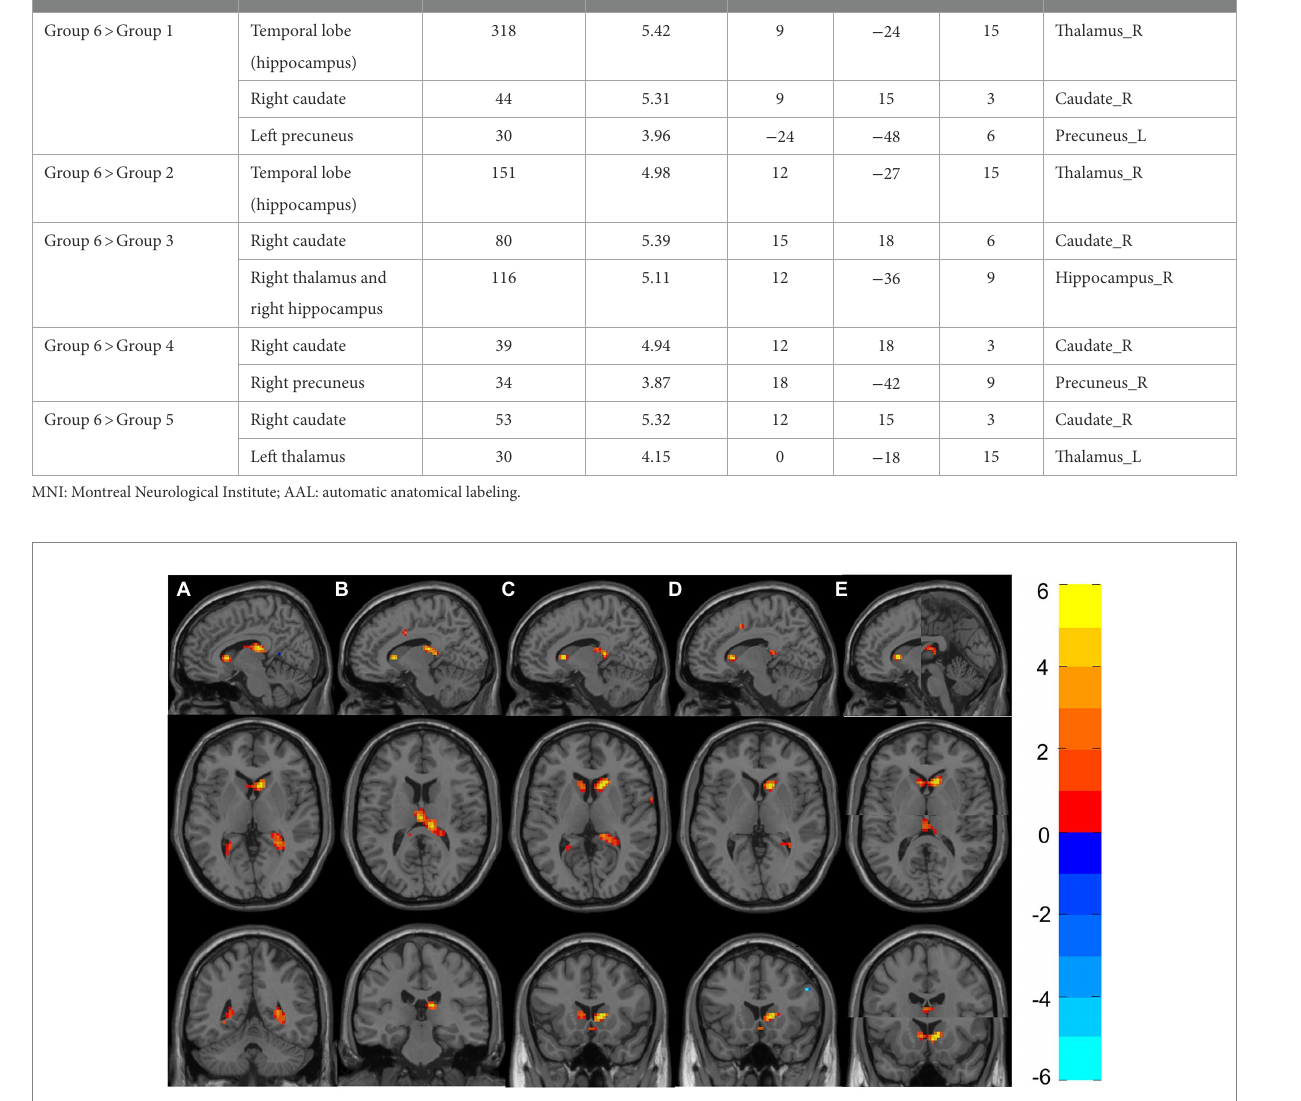
FIGURE 2 Representation of significant differences between Group 6 and Groups 1–5 in the ReHo analyses. (A) Shows the sagittal, axial and coronal planes with the differences between Group 6 and Group 1. Likewise, (B–E) Represent the differences between Group 6 against Groups 2–5. (E) The two clusters (Right Caudate and Left Thalamus) that appeared to be significant; therefore, two images are shown in each plane. The color bar indicates the intensity of the difference, with 6 (yellow) representing positive differences and –6 (light blue) negative